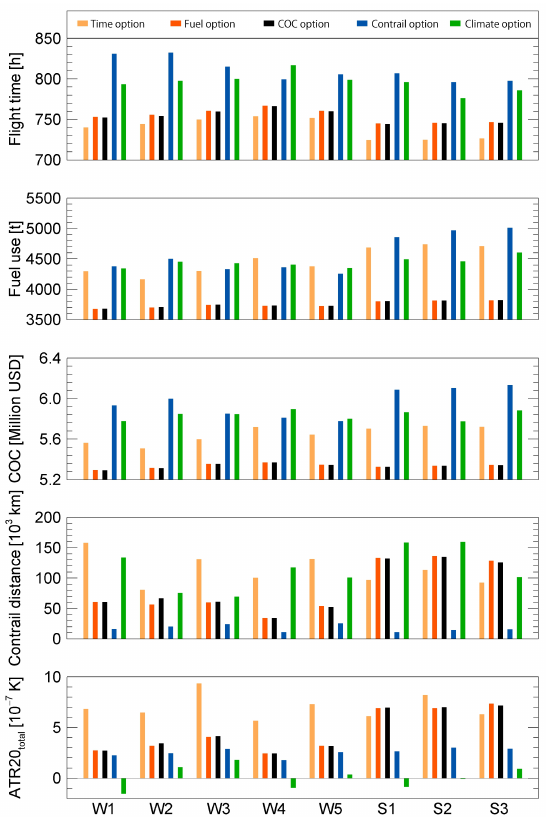
Figure 3. Flight characteristics obtained from the one-day air traffic simulations for representative 3 days of each weather type over the North Atlantic. The bars indicate the sum of 103 flights flying with different aircraft routing options. ATR20 total is calculated by the algorithmic climate change functions ( aCCFs) (see text for